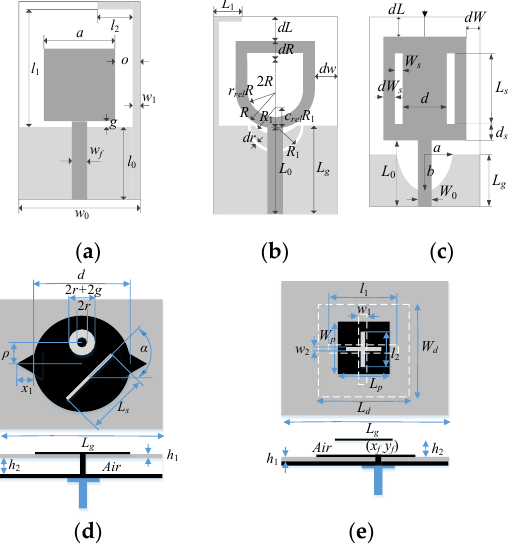
Figure 6. Topologies of the benchmark antennas: ( a ) Antenna I, ( b ) Antenna II, ( c ) Antenna III, ( d ) Antenna IV, ( e ) Antenna V.